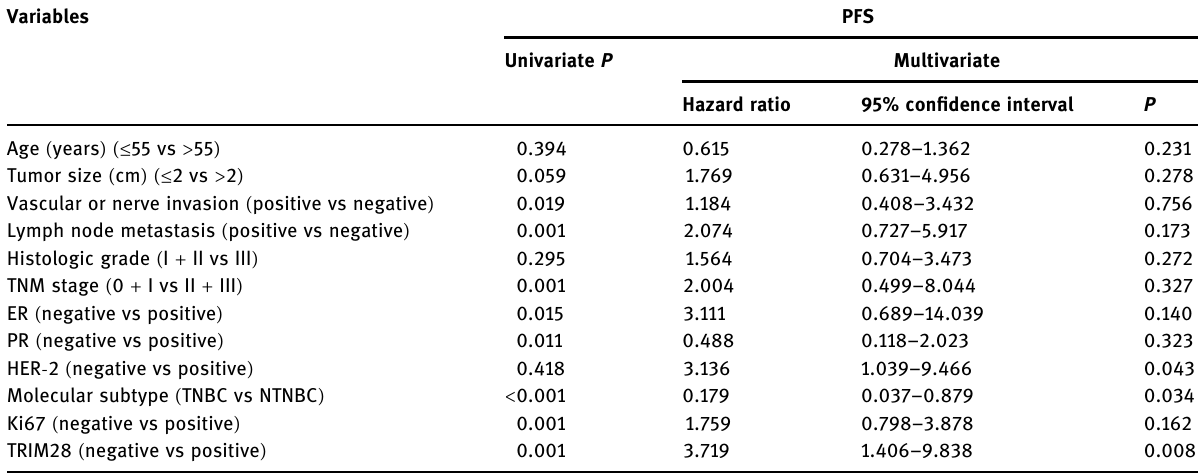
Table 3: Univariate and multivariate Cox regression analysis of progression - free survival in 114 breast cancer patients Variables